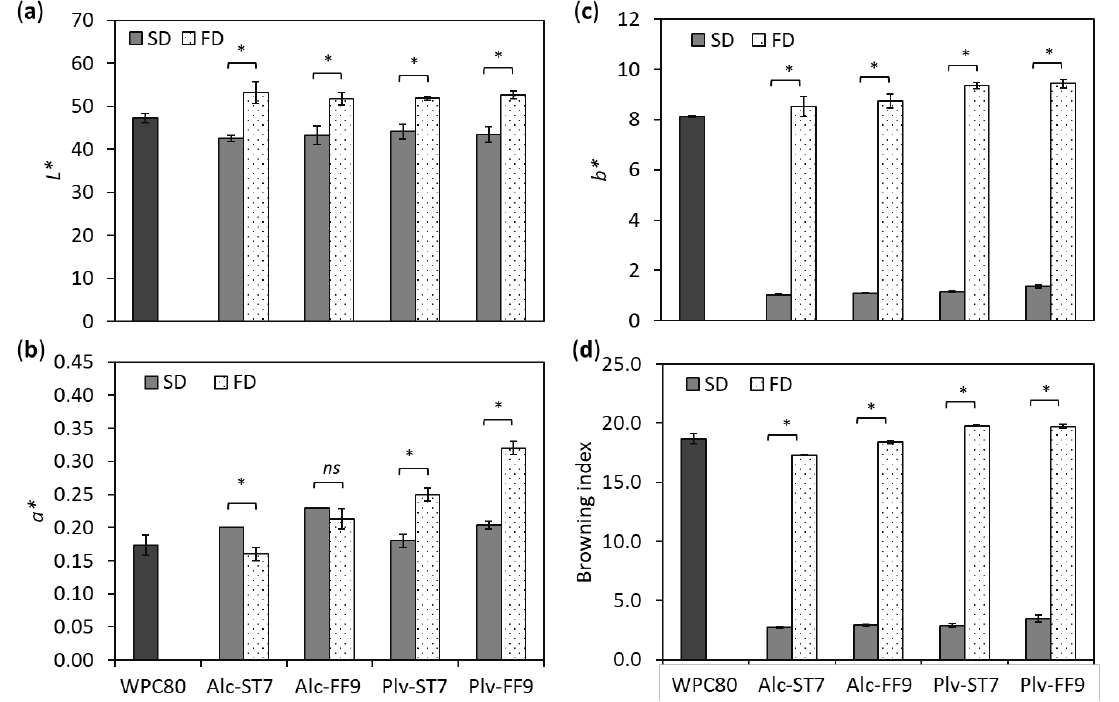
Figure 1. Colour parameters ( a ) lightness ( L* ), ( b ) redness ( a* ), ( c ) yellowness ( b* ) and ( d ) browning index of whey protein concentrate (WPC80) and spray-dried (SD) and freeze-dried (FD) whey protein hydrolysates prepared using Alcalase ® (Alc) and Prolyve ® (Plv) obtained under pH-stat at pH 7.0 (ST7) and free-fall pH 9.0 (FF9) hydrolysis conditions. Results represent mean ± SD ( n = 3). * denotes significant difference at p < 0.05; ns = no significant difference ( p > 0.05).